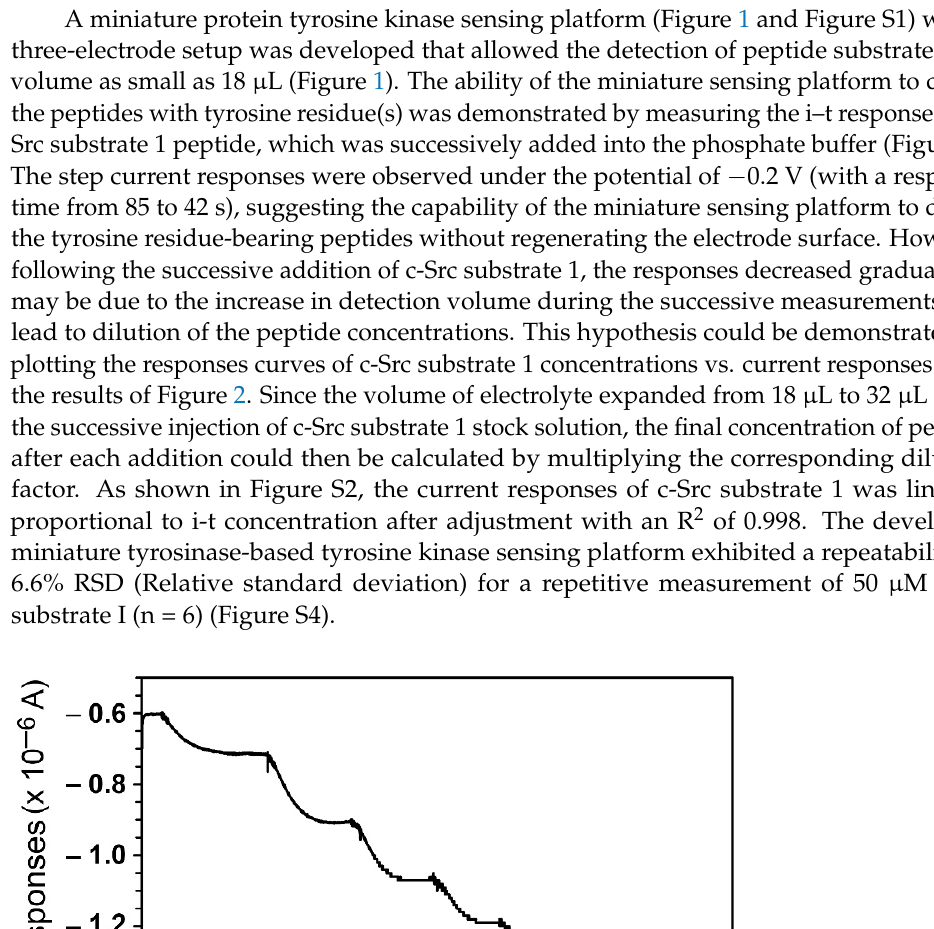
Figure 1. Close up view of the miniature protein tyrosine kinase sensing platform . The organiza- tion of working, counter and reference electrodes in the platform was revealed in the picture ( Left ) and the diagram ( Right ).